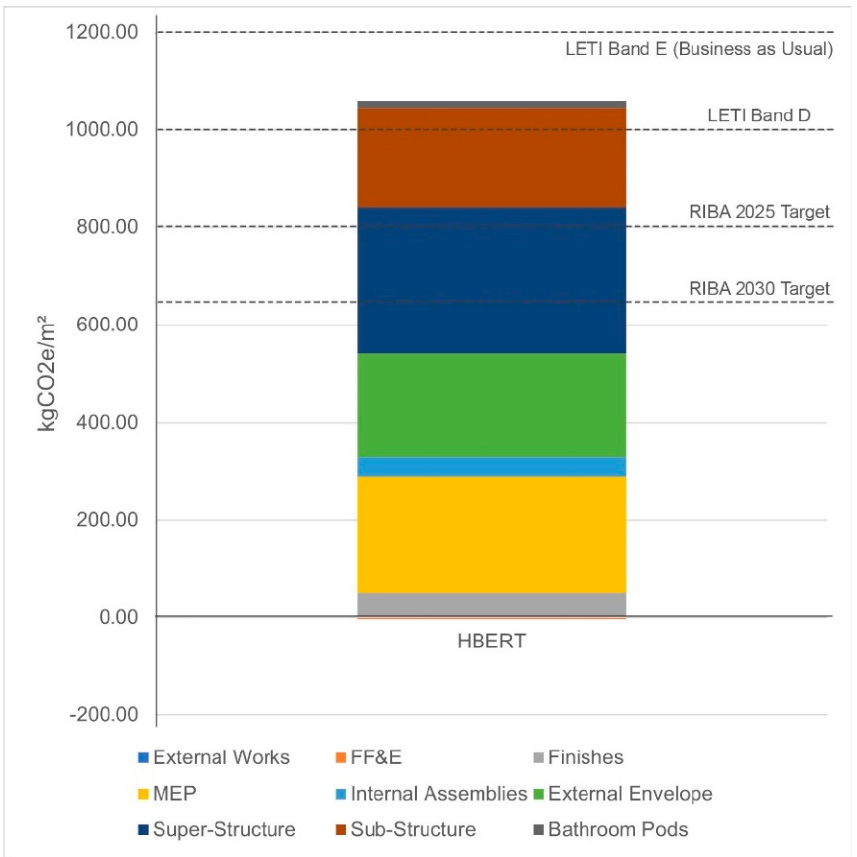
Figure 10. EVn6 LCA results compared against LETI and RIBA targets for residential buildings. Looking further to the LCA subcategories, most impacts come from the structural elements due to the high levels of concrete and steel usage. While substructure and superstructure emissions cover 42% of the GLA’s Whole Life Cycle Assessment (WLCA) benchmark for residential buildings [19], Portlands Place sets a slightly higher trend with 47%. Considering the much more detailed assessment process carried out in the LCA compared to more high-level approaches with a low level of detail in building components in the sector [32], this is acceptable. Another significant contributor is the façade modules, with about 20% 213 kgCO 2e /m 2 , or around 20%, which shares a bigger portion in the GLA WLCA benchmark, 23% (Figure 11). Because the façade panels are produced offsite, with low cut-off materials and less labour, the building, including the prefab methods and the construction, has a lowering impact on carbon emission in the façade category in the LCA. Internal assemblies also draw much lower figures; this may be simply because the bathroom pods are being produced off-site, while bathrooms normally involve a complex installation process in on-site